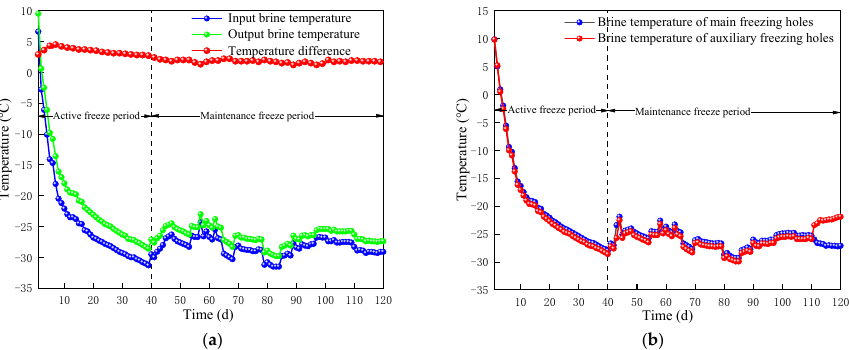
Figure 5. Measured brine temperature. ( a ) Measured temperature of the input brine and output brine; ( b ) measured brine temperature of main freezing hole and auxiliary hole.